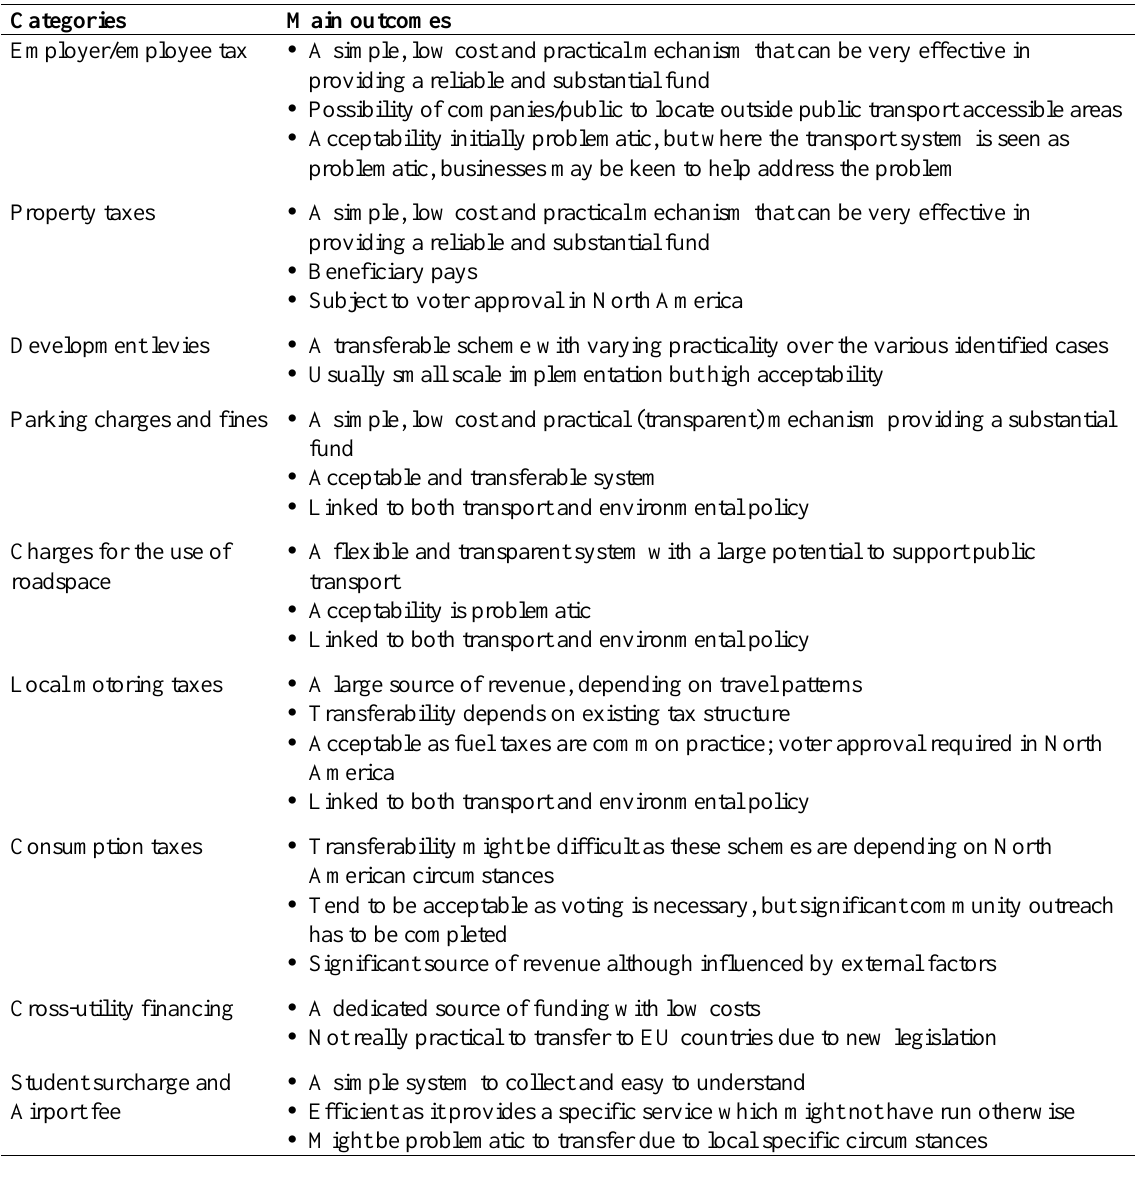
Table 2. Main outcomes of the assessment of unconventional funding categories Categories Main